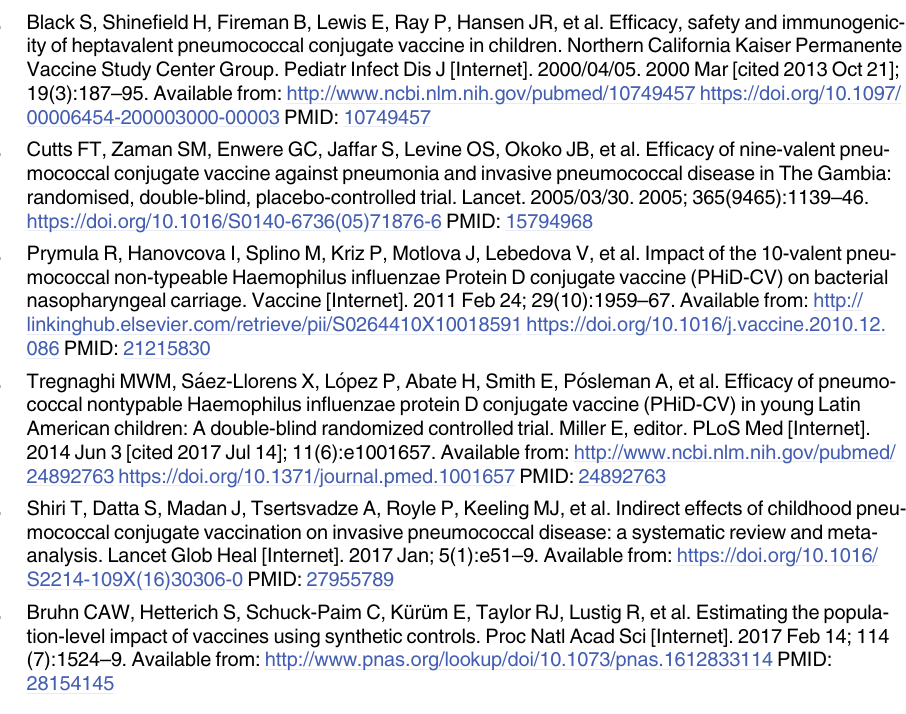
S1 Table. The weights used to produce the final stacked model from the component mod-